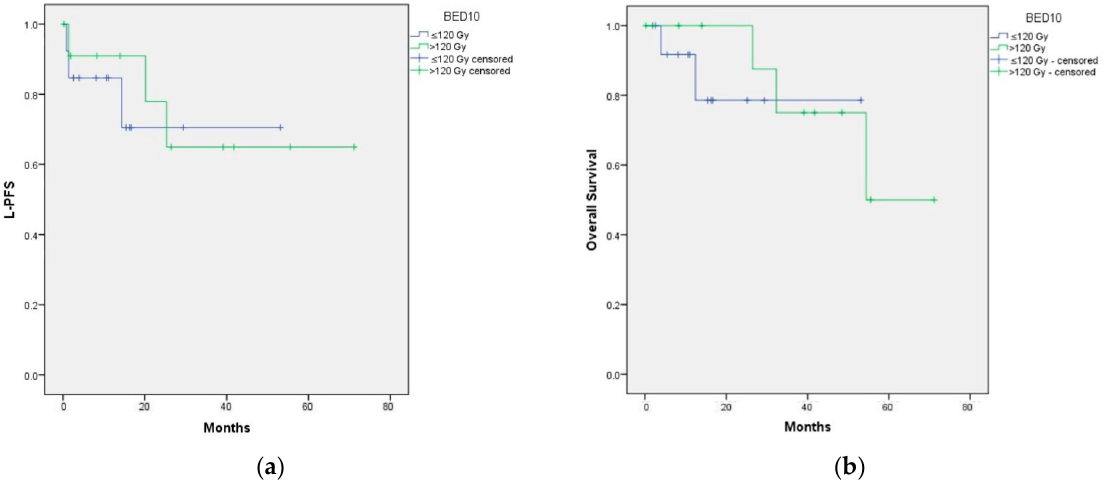
Figure A4. ( a ) Impact of BED on OS; ( b ) impact of BED on L-PFS.